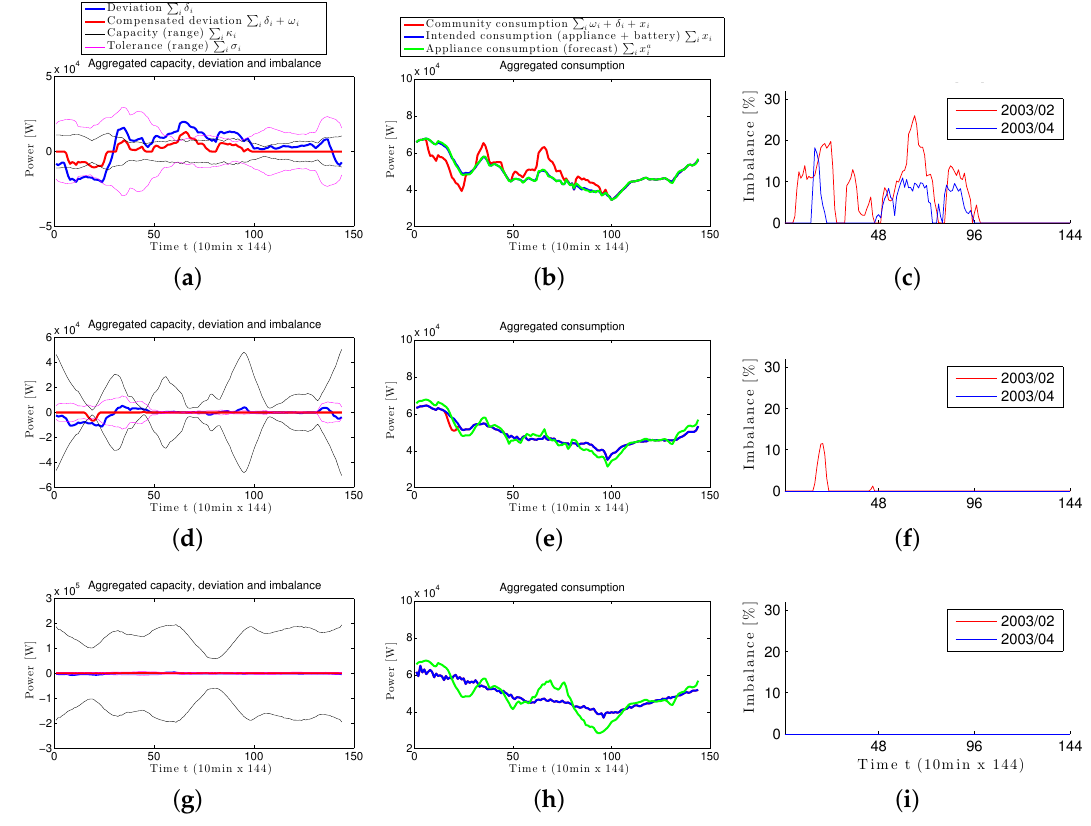
Figure 13. Augmented day-ahead coordination. Date: 2003/02. Rows indicate battery size: ¯ C ∈ { 0.3 × 700,700,3 × 700 } Wh . Left column: capacity, tolerance, deviation and compensated deviation. Middle column: actual, intended and appliance consumption. Right column: community imbalance (see main text for definition) for two different dates (2003/02 and 2003/04). Note: the figures have different scales in the y-axis for easier visualization. ( a ) ¯ C = 0.3 × 700 Wh ; ( b ) ¯ C = 0.3 × 700 Wh ; ( c ) ¯ C = 0.3 × 700 Wh ; ( d ) ¯ C = 700 Wh .; ( e ) ¯ C = 700 Wh .; ( f ) ¯ C = 700 Wh ; ( g ) ¯ C = 3 × 700 Wh ; ( h ) ¯ C = 3 × 700 Wh ; ( i ) ¯ C = 3 × 700 Wh .